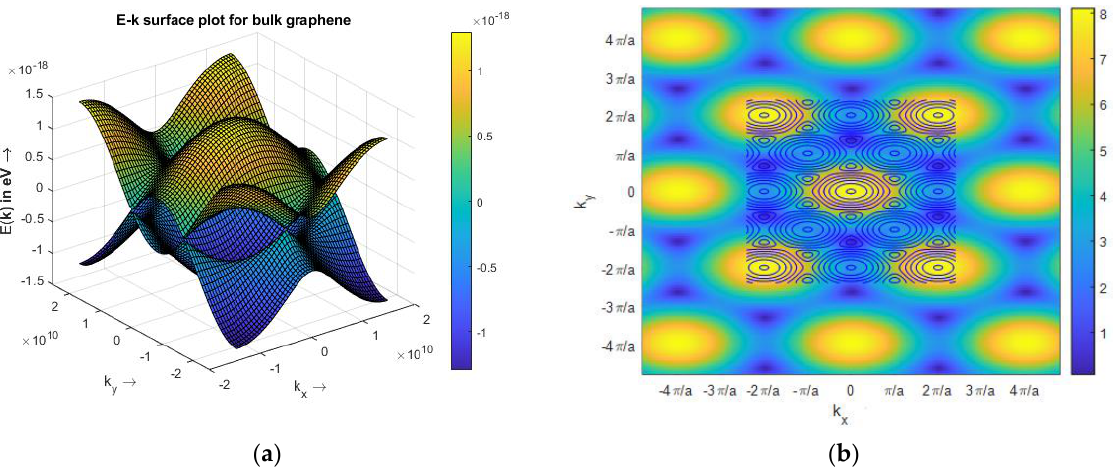
Figure 4. Band structure of graphene. ( a ) E – K surface plot for bulk graphene; ( b ) contour plot of conduction band.